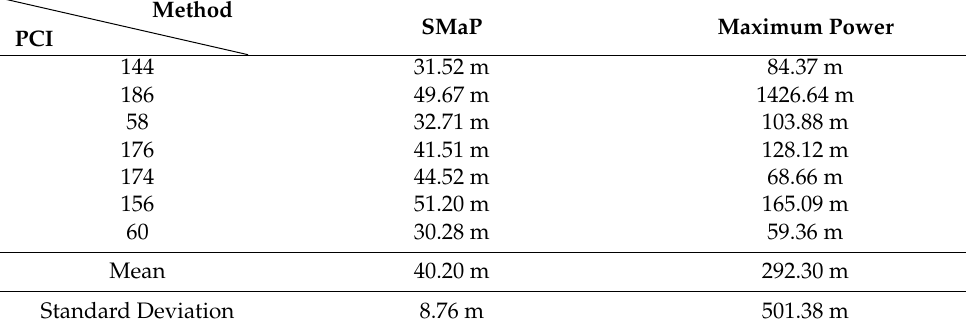
Table 2. Summary of positioning errors according to positioning